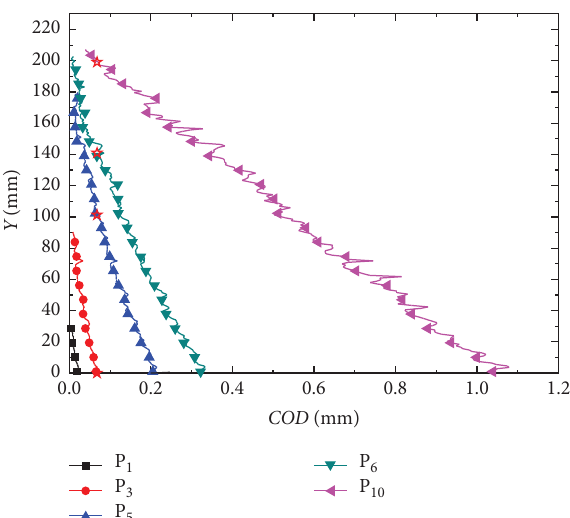
Figure 10: Te variation of COD of specimen WS 300-0.3 at typical loading